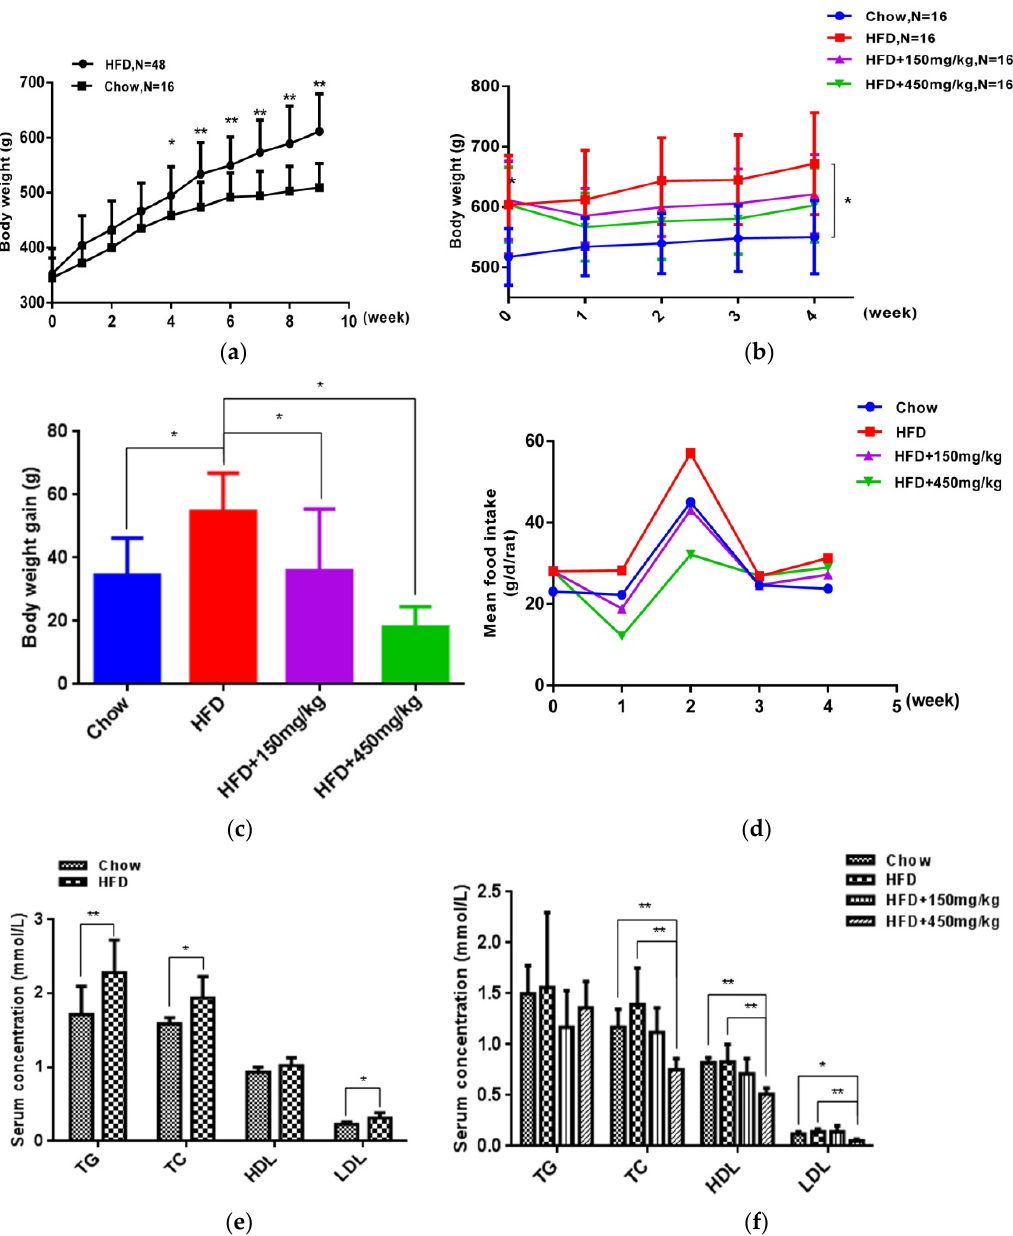
Figure 1. Soy isoflavones reduced the body weight and the blood lipid concentrations. ( a ) Body weights of rats in the chow group and the HFD group during nine-week fed with high fat diet; ( b ) Body weights of rats in each group during supplementation with SIF; ( c ) Body weights gain of rats in each group between week nine and week thirteen; ( d ) Food intake of a rat for one day in each group during supplementation with SIF; ( e ) The plasma TG, TC, HDL and LDL concentrations of rats in the chow group and the HFD group at the ninth week; ( f ) The plasma TG, TC, HDL and LDL concentrations of rats in each group at the thirteenth week. Error bars indicate SD. * p < 0.05, ** p < 0.005.